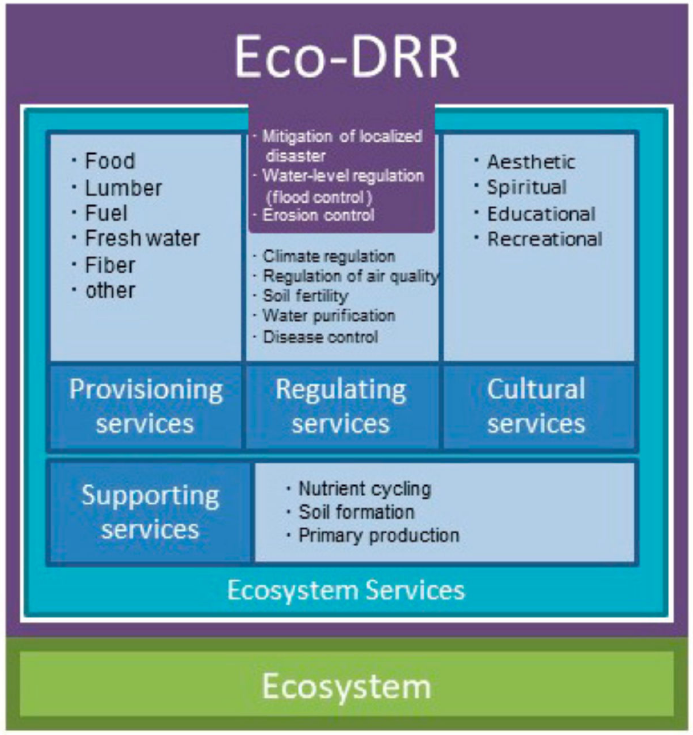
Figure 12. Position of ecosystem-based disaster risk reduction (Eco-DRR) in ecosystem